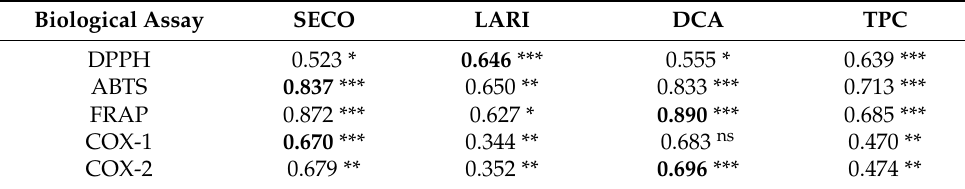
Table 3. Pearson correlation coefficients (PCC) showing the relation between the main phytochemicals and the biological activities (antioxidant and anti-inflammatory) of extracts of in vitro cultures of L. grandiflorum (L.).